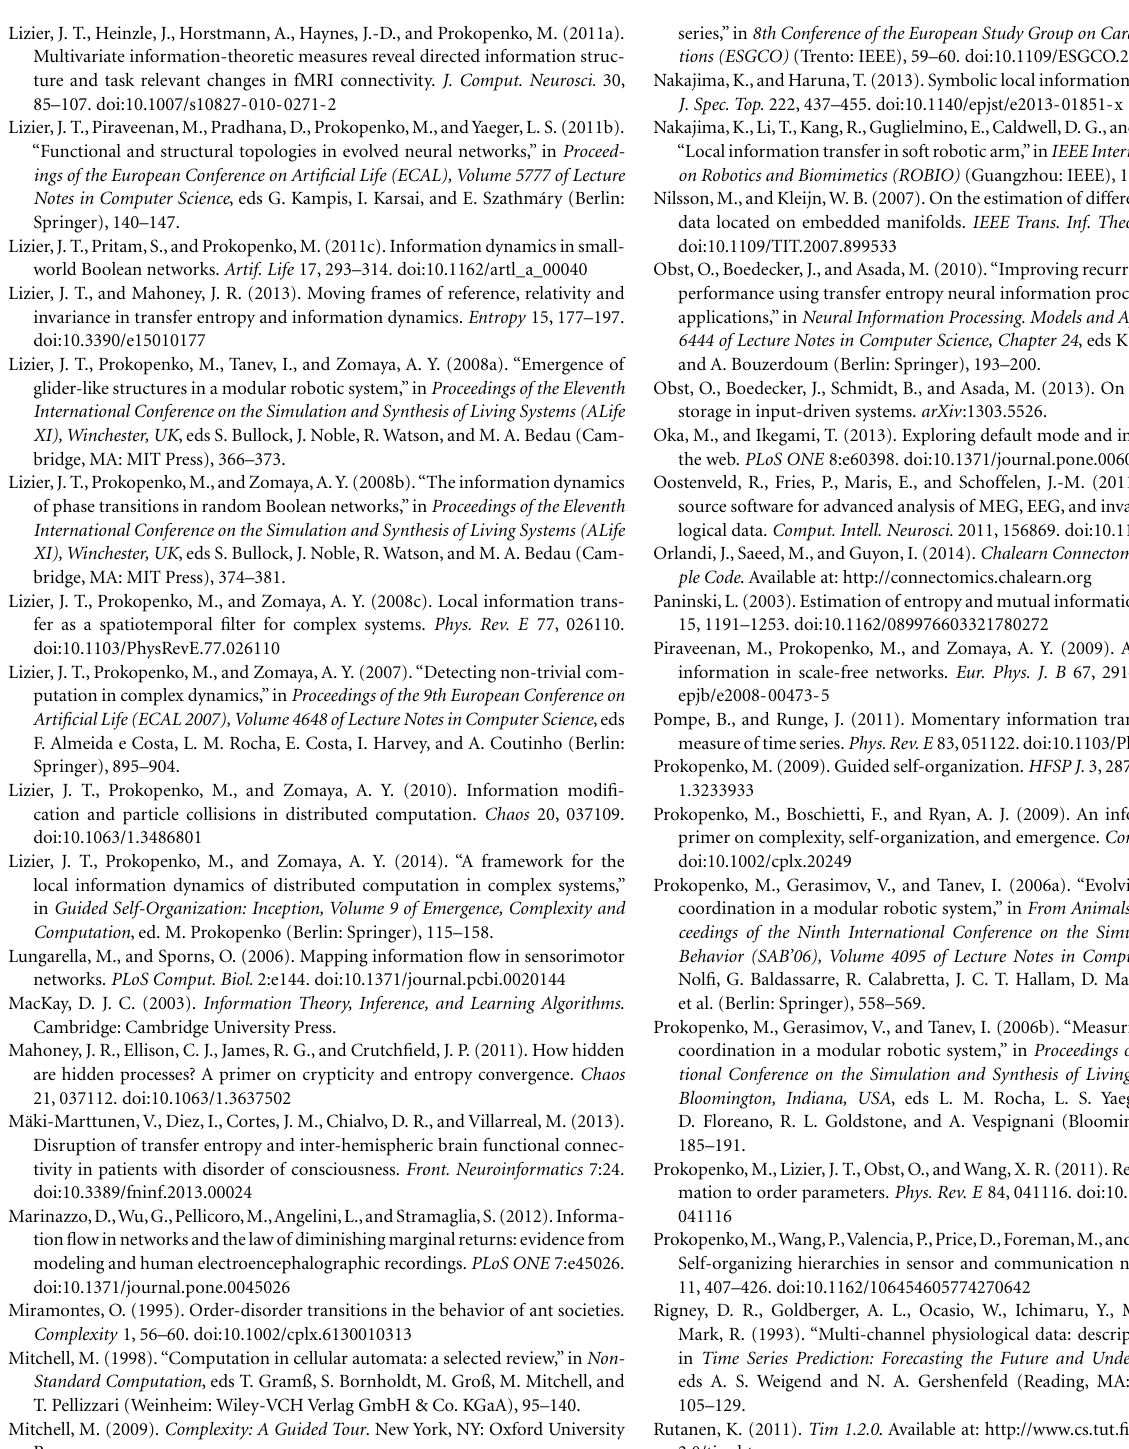
Figshare. Available at: http://dx.doi.org/10.6084/m9.figshare.1005245 Montalto, A., Faes, L., and Marinazzo, D. (2014a). MuTE: a MATLAB toolbox to compare established and novel estimators of the multivariate transfer entropy. PLoS ONE 9:e109462.